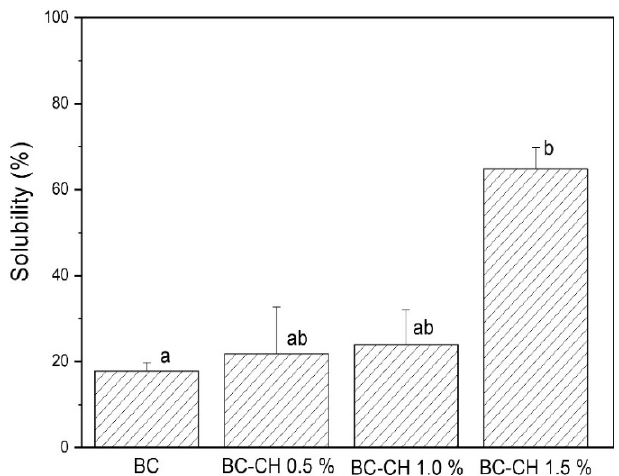
Figure 9. Solubility of BC and BC-CH films coated with various concentrations of chitosan. Average ± standard deviation. Letters (a, b) indicate significant differences ( p < 0.05) between treatments.